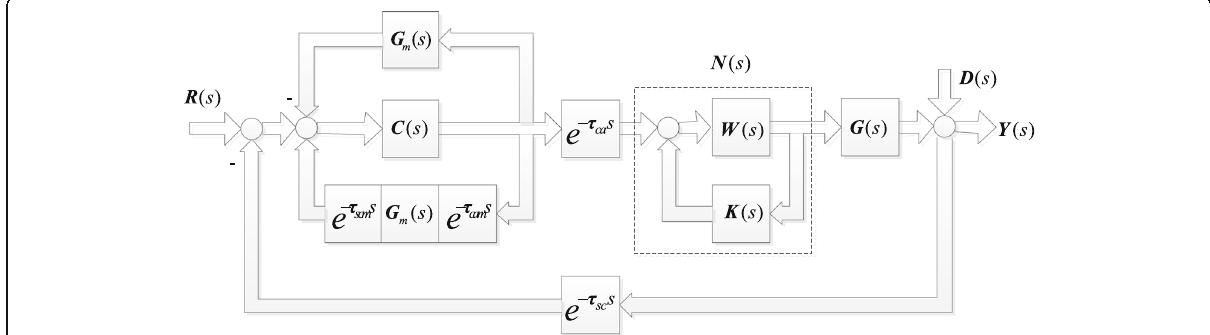
Fig. 3 The classic Smith predictor and v-norm decoupling